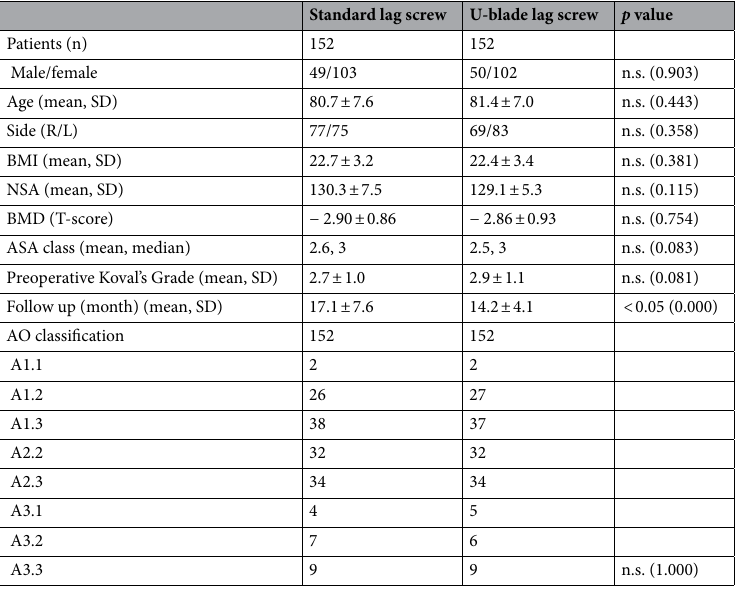
Table 1. Patient